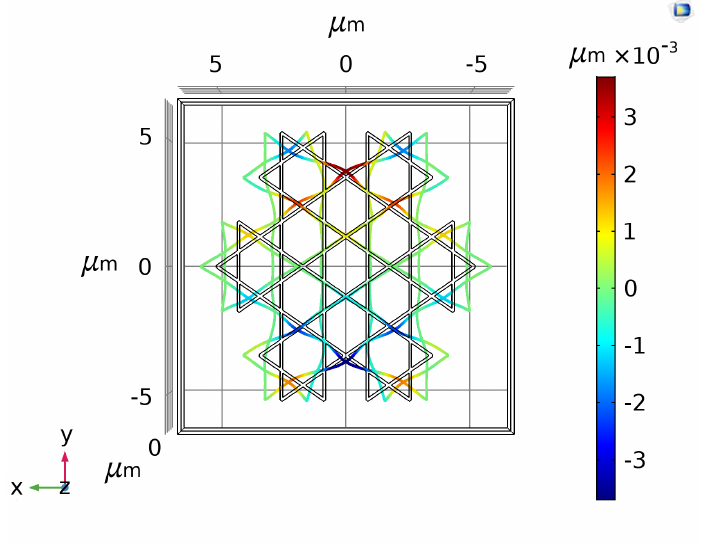
Figure A12. FEM simulation of the displacement of the structure when it is stretched along x -axis. The colours denote the y -component of the displacement where red is positive and blue negative displacement in micrometers, see the legend. Note that the center of the structure is at x = 0, y =